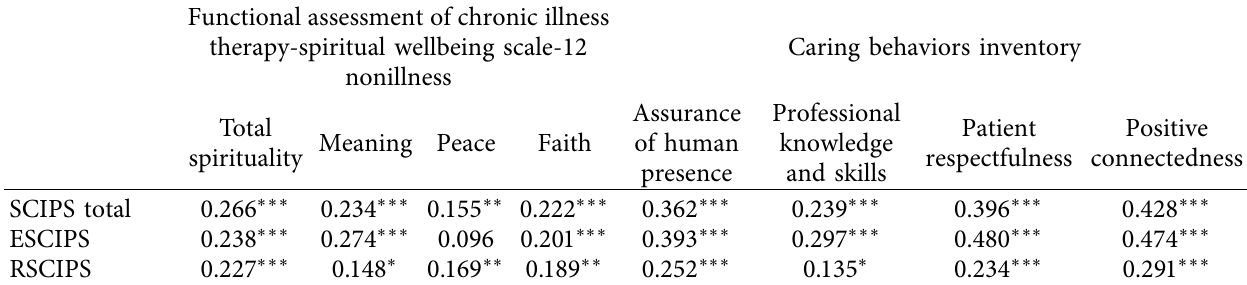
Table 4: Correlations between the scores of the SCIPS and the FACIT-SP12 and CBI